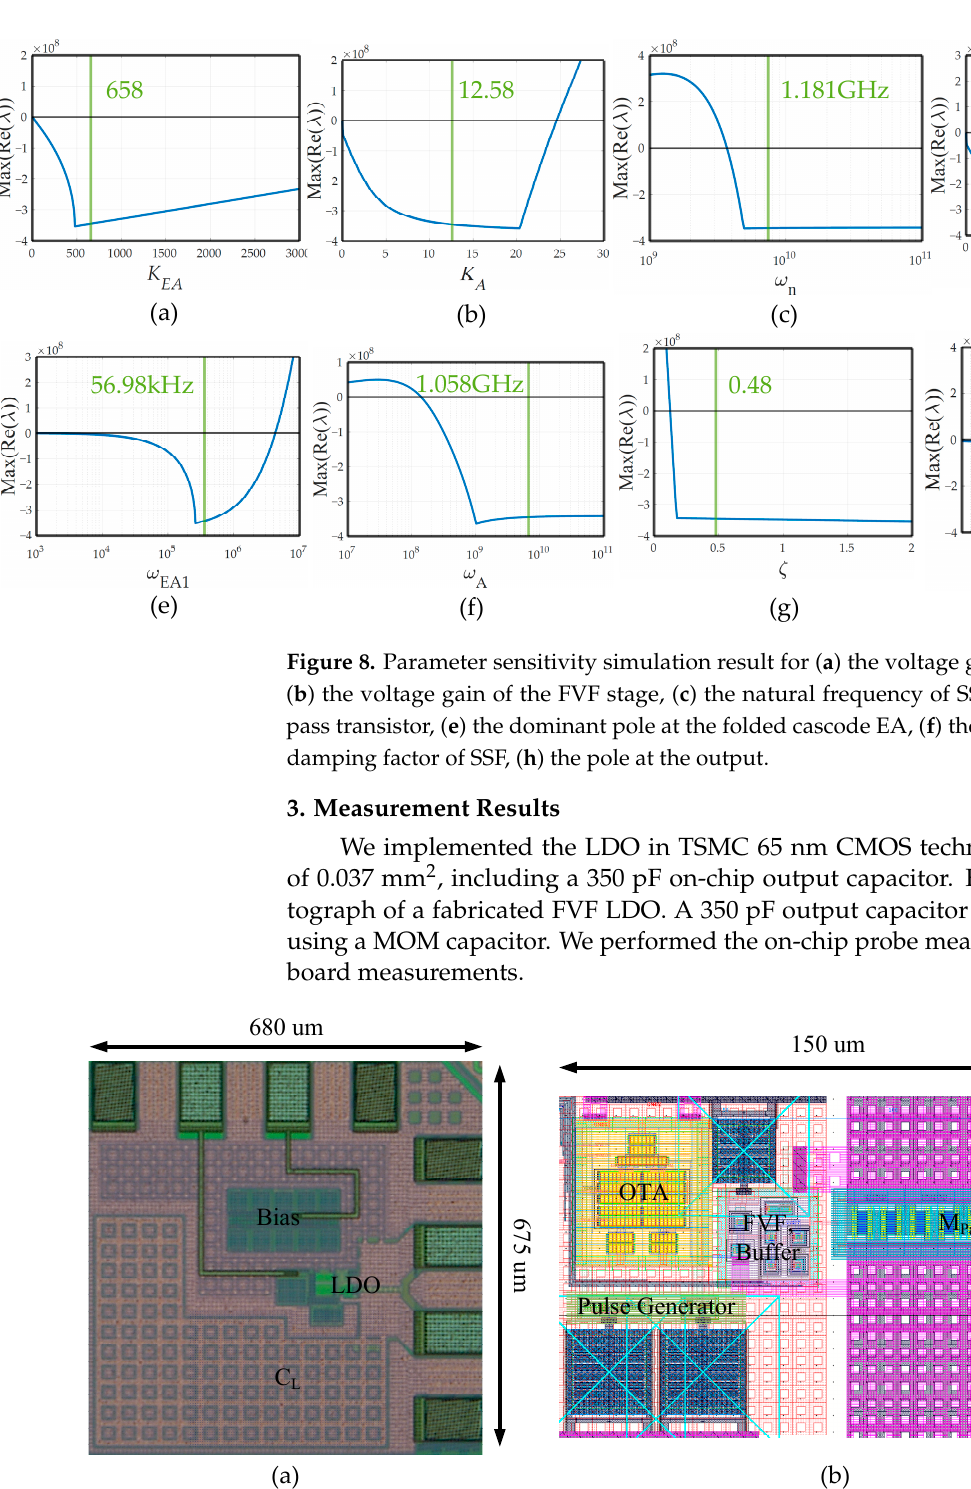
Figure 9. ( a ) Chip photograph of the fabricated FVF LDO and ( b ) layout of the FVF LDO.